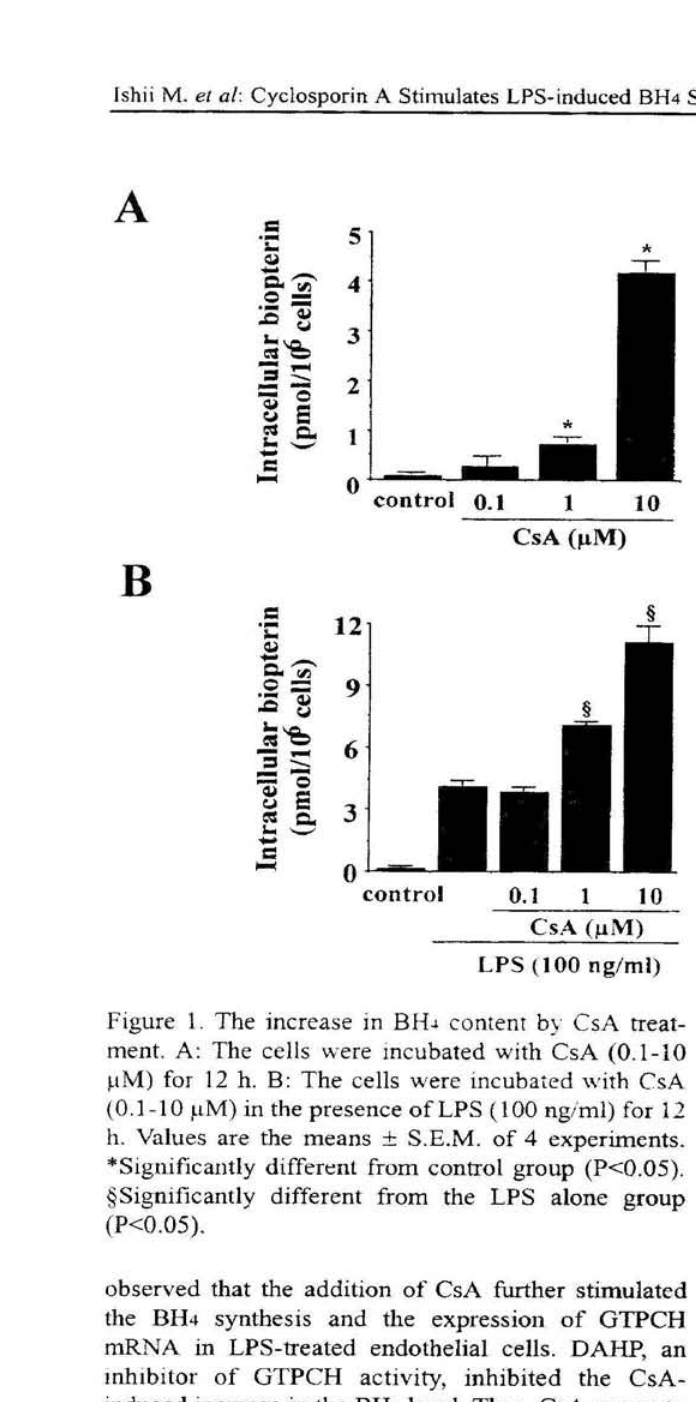
Figure 1. The increase in BH-t content by CsA treat- ment. A: The cells were incubated with CsA (0.1-10 μΜ) for 12 h. B: The cells were incubated with CsA (0.1-10 μΜ) in the presence of LPS (100 ng/ml) for 12 h. Values are the means i S.Ε.M. of 4 experiments.